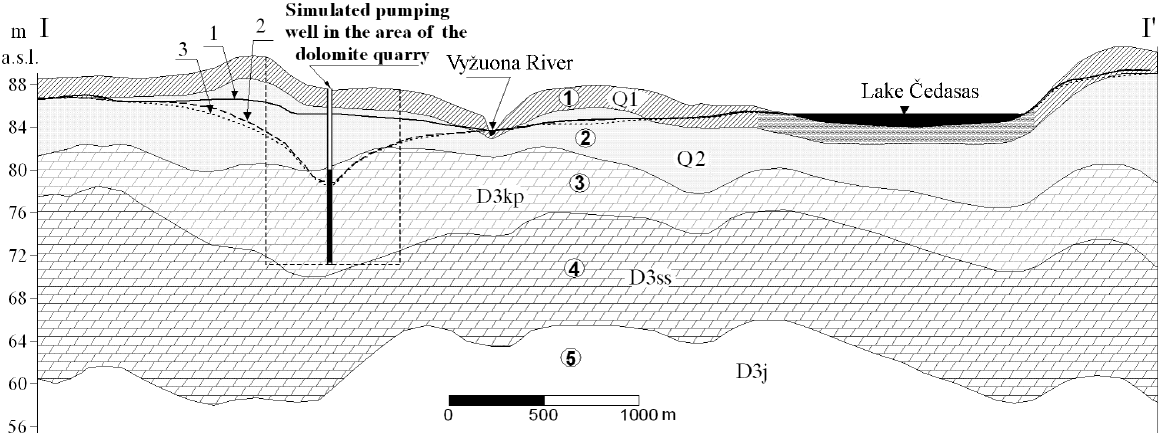
Fig. 9. Geological(cid:150)lithological cross section along line I(cid:150)I ′ (Fig. 2) and simulated groundwater level: 1, according to natural groundwater regime prior to the beginning of exploitation of the dolomite quarry; 2, according to the affected groundwater regime, after eight years of exploitation of the dolomite quarry (the 4th-kind boundary condition (cid:150) extraction of water from the quarry with a constant yield of 158.3 m 3 h (cid:150)1 ); 3, after eight years of exploitation of the dolomite quarry in case of reduced groundwater recharge due to climate change. Numbers in circles (1(cid:150)5) (cid:150) layers according to Table